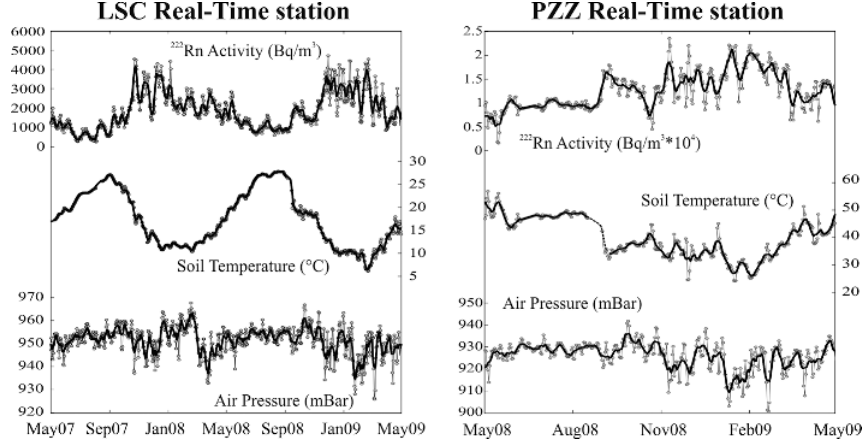
Figure 3: Time-series of the first years of real-time radon monitoring with the two distinct fully-automated stations at the Stromboli